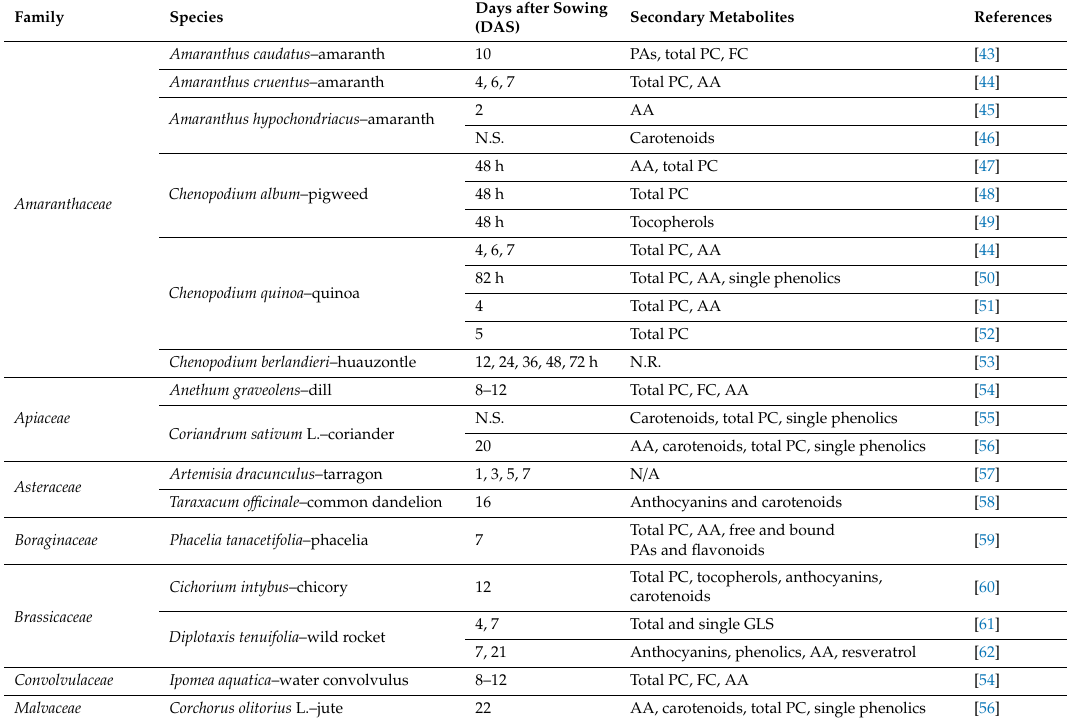
Table 3. Micro-scale vegetables from voluntary species, wild relatives, and ancient species. Family Species Days after Sowing (DAS) Secondary